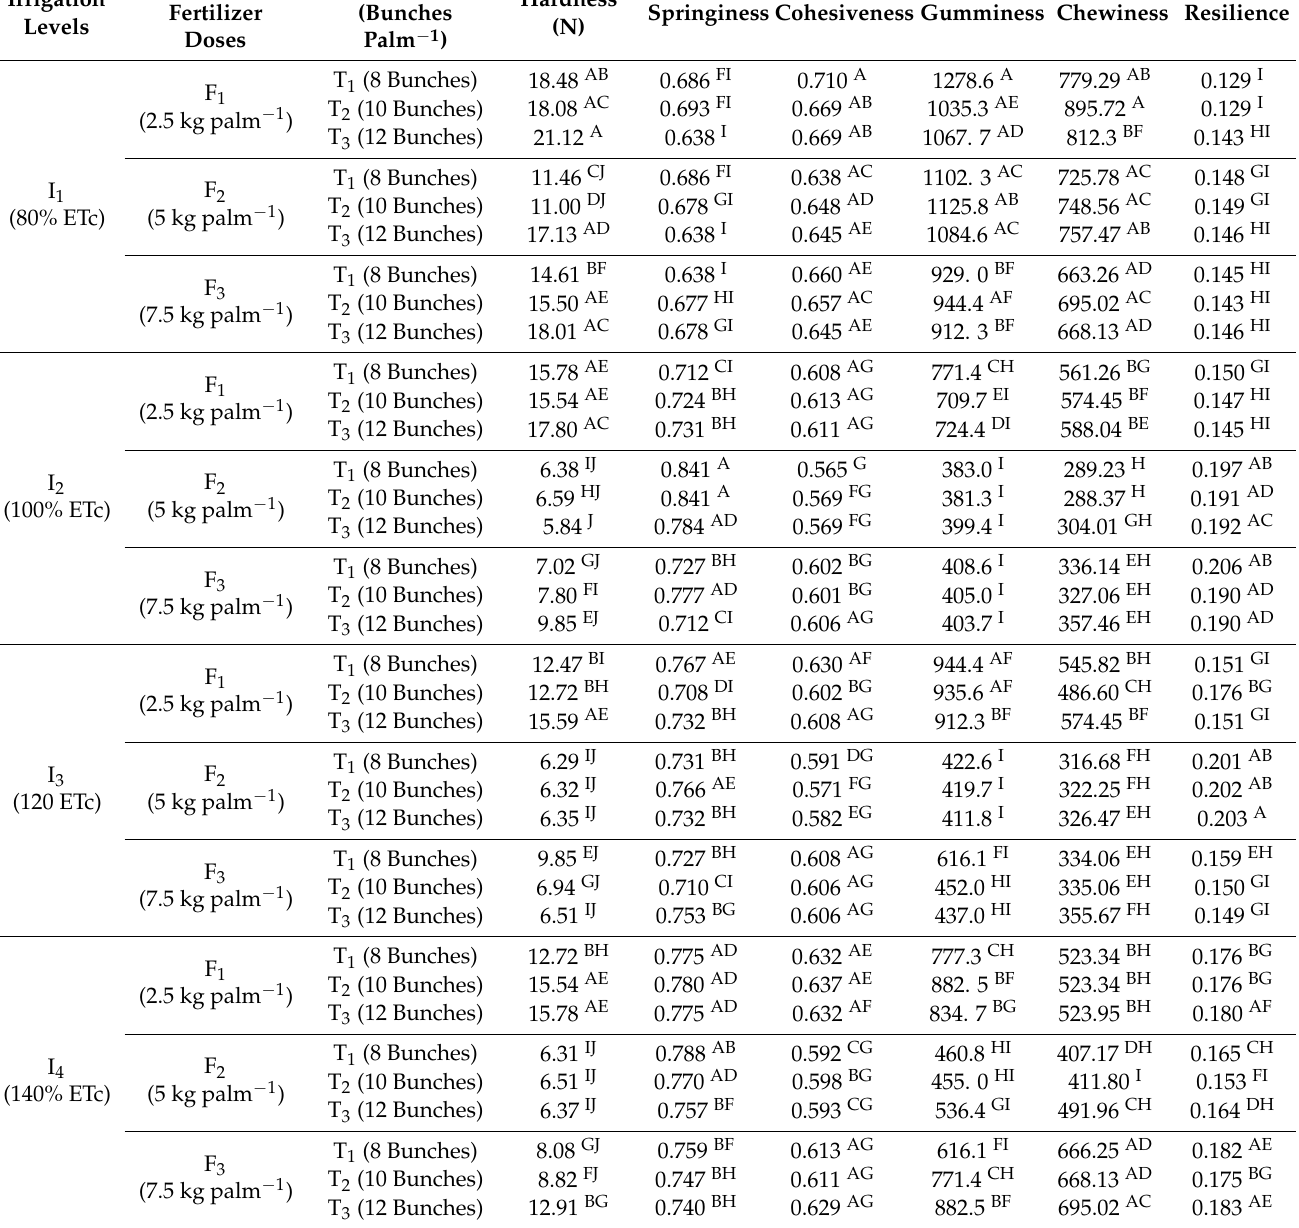
Table 4. Effects of irrigation levels, SOP fertilizer doses, and bunch thinning levels on the hardness, springiness, cohesiveness, gumminess, chewiness, and resilience of date palm cv. Sukary. Each mean data represents the averages from two seasons,